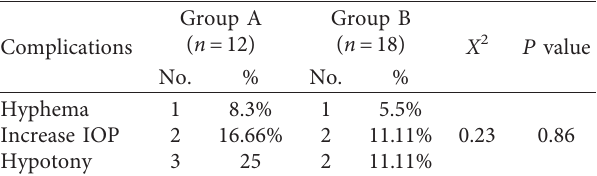
Table 6: Comparison of postoperative complications between the two